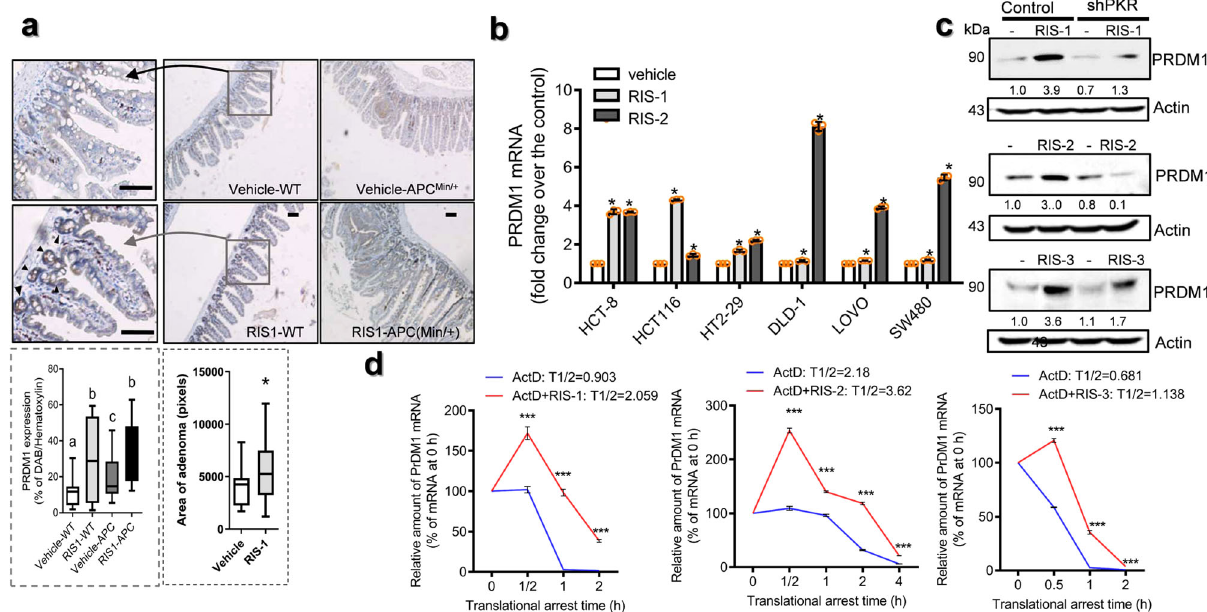
Fig. 4 PRDM1 expression in ribosome-inactivated CRC cells. a Wild type or APC Min/ + mice ( n = 3 – 5) were treated with 25 mg/kg RIS-1 for 72 h, after which the PRDM1 levels in the small intestine were measured using immunohistochemistry with hematoxylin staining (magni fi cation ×100; scale bar(s), 50 μ m). The arrows indicate higher levels of PRDM1 expression in the crypt than in the villi. Quanti fi cation of PRDM1 staining from IHC analysis (the lower graph) and relative area of adenoma in the gut. Results are shown as a plot with Tukey whiskers and different letters (a – c) over each box represent signi fi cant differences between groups (the lower left graphs, n = 12 – 20, P < 0.05). Asterisks represent a signi fi cant difference compared to each vehicle group (the lower right graph, n = 16 – 39, P < 0.05). b PRDM1 mRNA expression was measured in the intestinal cancer cells treated with ID 90 of RIS-1 or RIS- 2 for 2 h. Results are shown as mean values± SD and asterisks represent a signi fi cant difference compared to each vehicle group ( n = 3, P < 0.05). c HCT-8 cells were transfected with control (the negative control shRNA) or shPKR plasmid. PRDM1 protein was detected in the HCT-8 cells treated with RIS-1 for 6 h, RIS-2 for 24 h or RIS-3 for 6 h (different times indicate points for each maximal expression of PRDM1). Total cell lysates were subjected to western blot analysis. d HCT-8 cells were treated with ID 90 of RIS for 8 h (RIS-1 or RIS-3) or for 2 h (RIS-2) and then added 5 μ M actinomycin D for the indicated time to arrest cellular transcription. Each mRNA level was measured using RT real-time PCR. Results are shown as mean values ± SD and asterisks ( ∗ ) indicate signi fi cant differences from the group without RIS treatment at each time point ( n = 3, *** P <